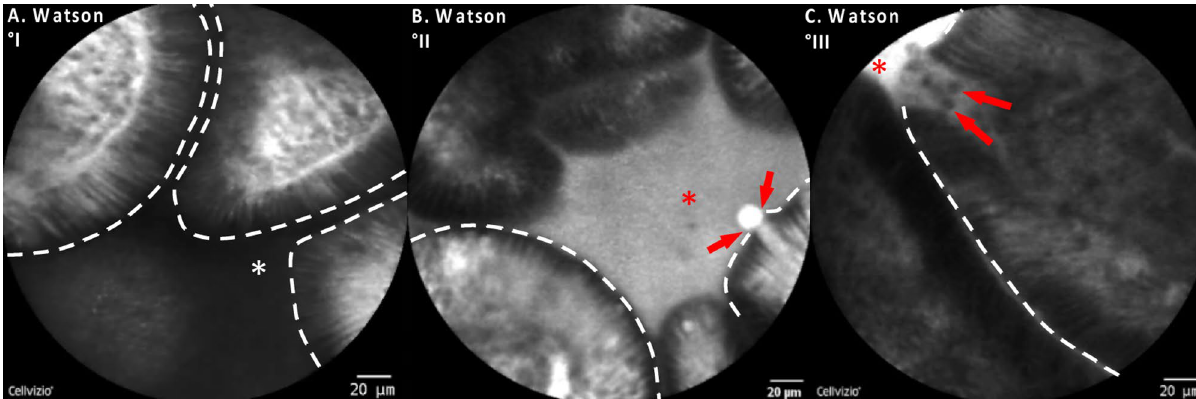
Figure 1. Semiquantitative grading of intestinal barrier dysfunction in the terminal ileum under CLE imaging. ( A ) Healthy terminal ileum (Watson Grade I): Healthy terminal ileum and intact epithelial barrier is characterized by finger-shaped villi with enterocytes forming the epithelial barrier. The intestinal lumen is dark when the intestinal barrier is intact (white asterisk). ( B ) Functional barrier (Watson Grade II) defect is characterized by shedding of single enterocytes generating a gap or loss of epithelial integrity with fluorescein leakage (red arrows) into the intestinal lumen which then turns bright (red asterisk). ( C ) Structural barrier defect (Watson Grade III) is characterized by shedding of multiple epithelial cells (red arrows) and fluorescein leakage into the lumen which as a consequence of fluorescein efflux turns bright (red asterisk). Dashed white line: apical border of the enterocytes forming the epithelial